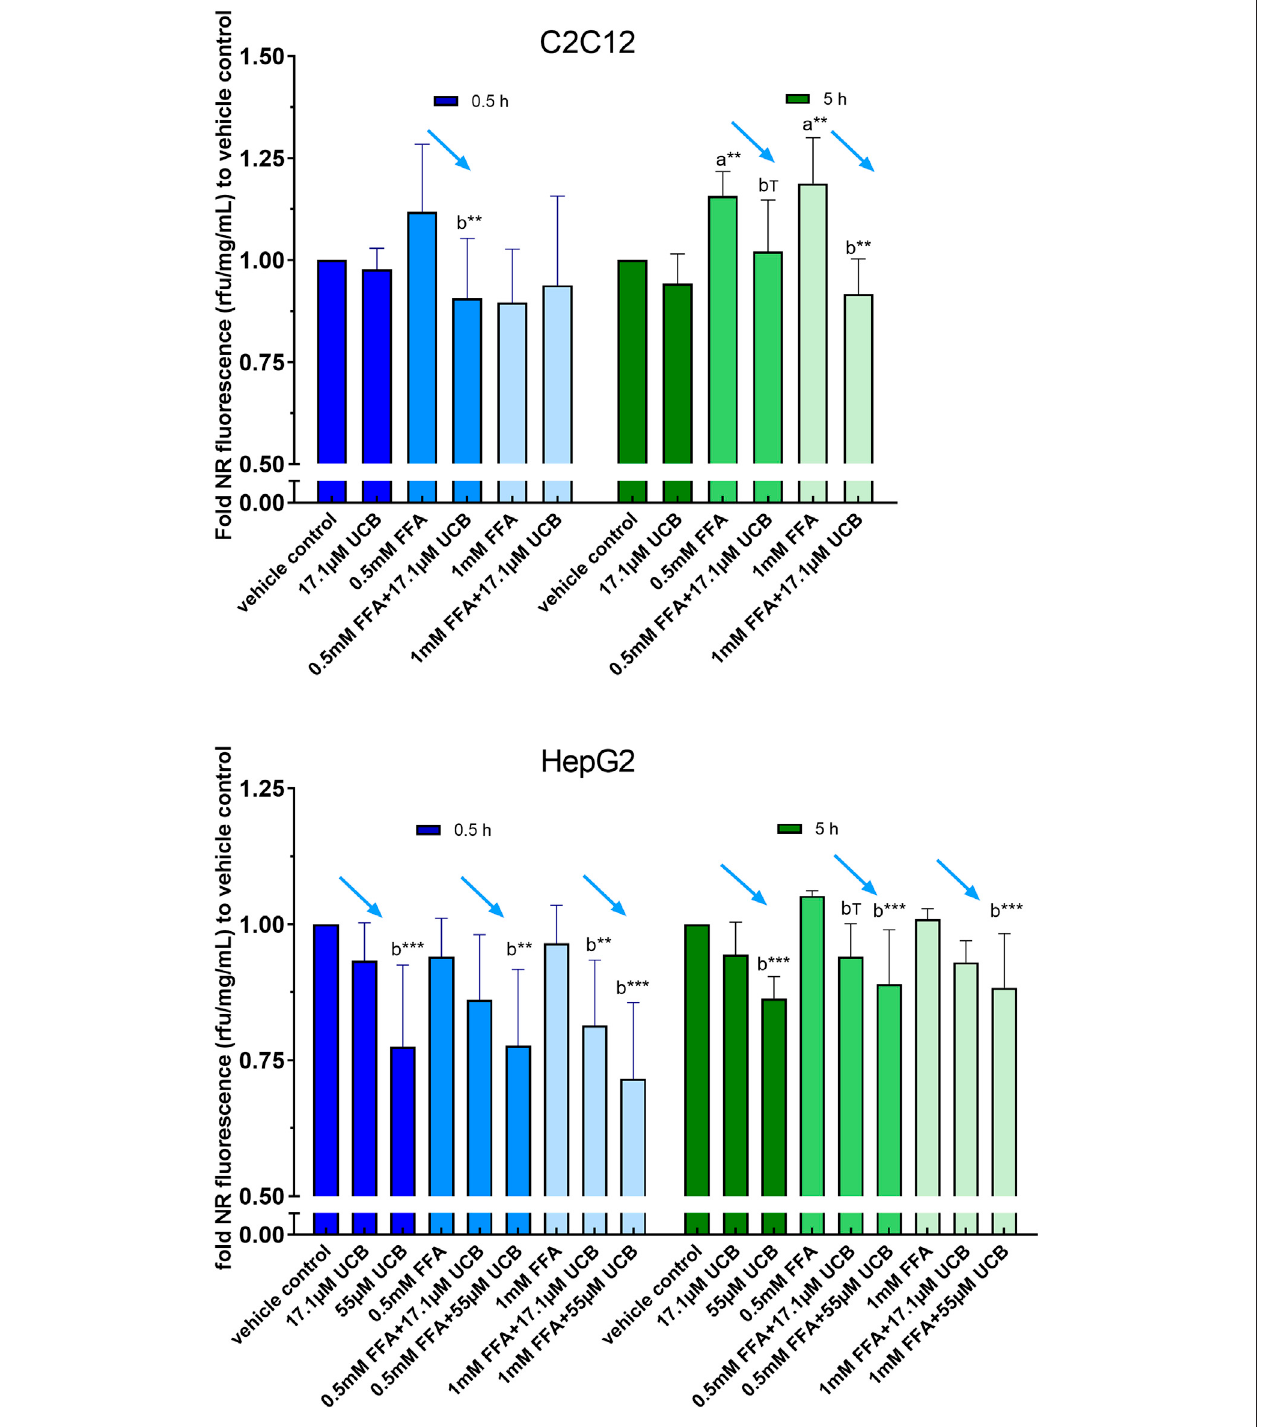
FIGURE7| UCBsigni fi cantlydecreasedlipid accumulation inC2C12 and HepG2cellsat hypoglycaemicconditions.Cells wereexposed totreatmentsfor0.5and 5 h. NR fl uorescence was adjusted by protein content (rfu/mg/mL) and compared to vehicle control. Data are mean ± SD of n (cid:2) 3 (each in quadruplicate). *** p ≤ 0.001, ** p ≤ 0.01, T p ≤ 0.1 of a (cid:2) compared to vehicle control and b (cid:2) compared to UCB treated vs. untreated cells according to Bonferroni.